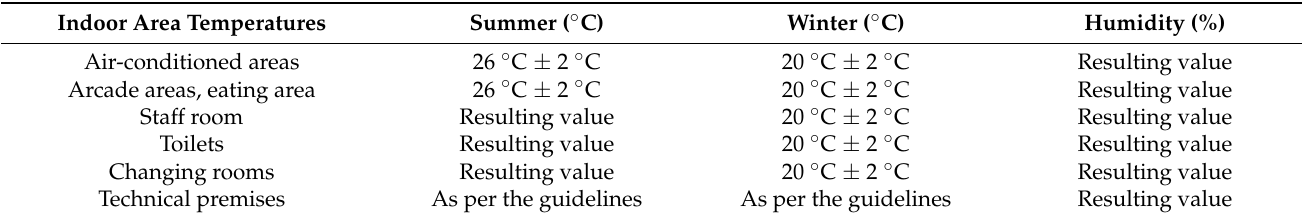
Table 1. Indoor air calculation parameters .